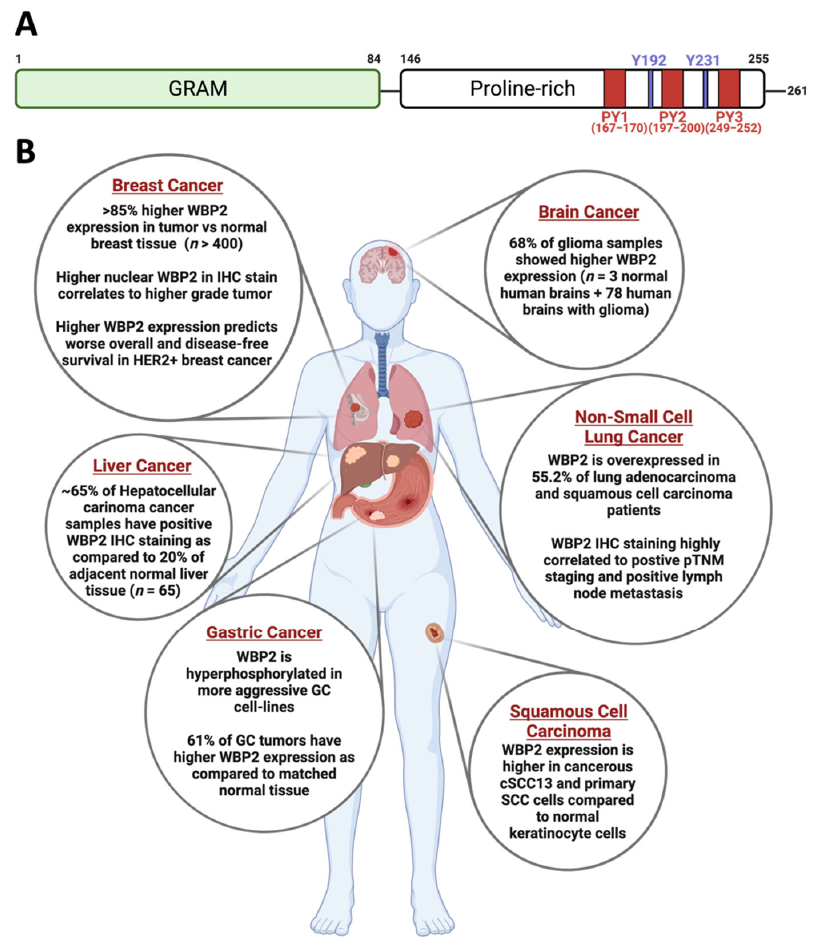
Figure 3. Structure and implications of WBP2 in various cancer types. ( A ) Schematic diagram of the WBP2 domain structure. WBP2 is comprised of the GRAM domain at the N terminus (1–84 amino acid (a.a)) and the proline-rich region at the C terminus (146–261 a.a). There are three PPxY motifs namely PY1 (167–170 a.a), PY2 (197–200 a.a) and PY3 (249–252 a.a) that have been identified as being involved in protein–protein interactions. Two phospho-tyrosine sites at Y192 and Y231 are found in the proline-rich region of WBP2. Phosphorylation of WBP2 is important for its nuclear translocation. ( B ) Implications of WBP2 in various cancer types based on the current literature. Created with BioRender.com .